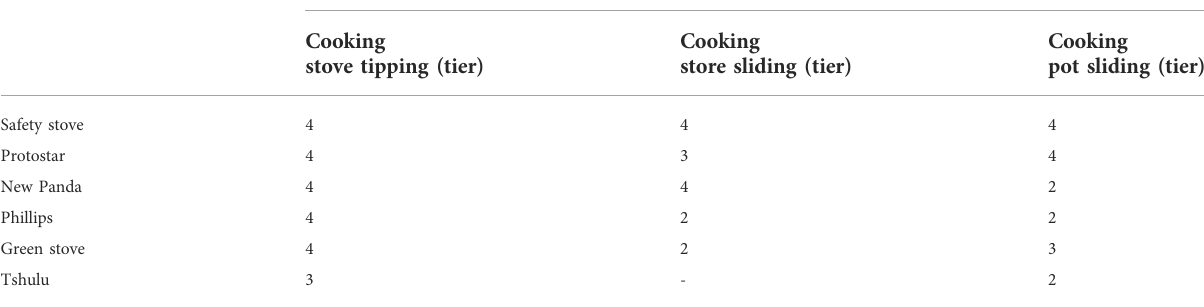
TABLE 4 Ranking of the mechanical stability of South African stoves based on the IWA safety protocol tipping